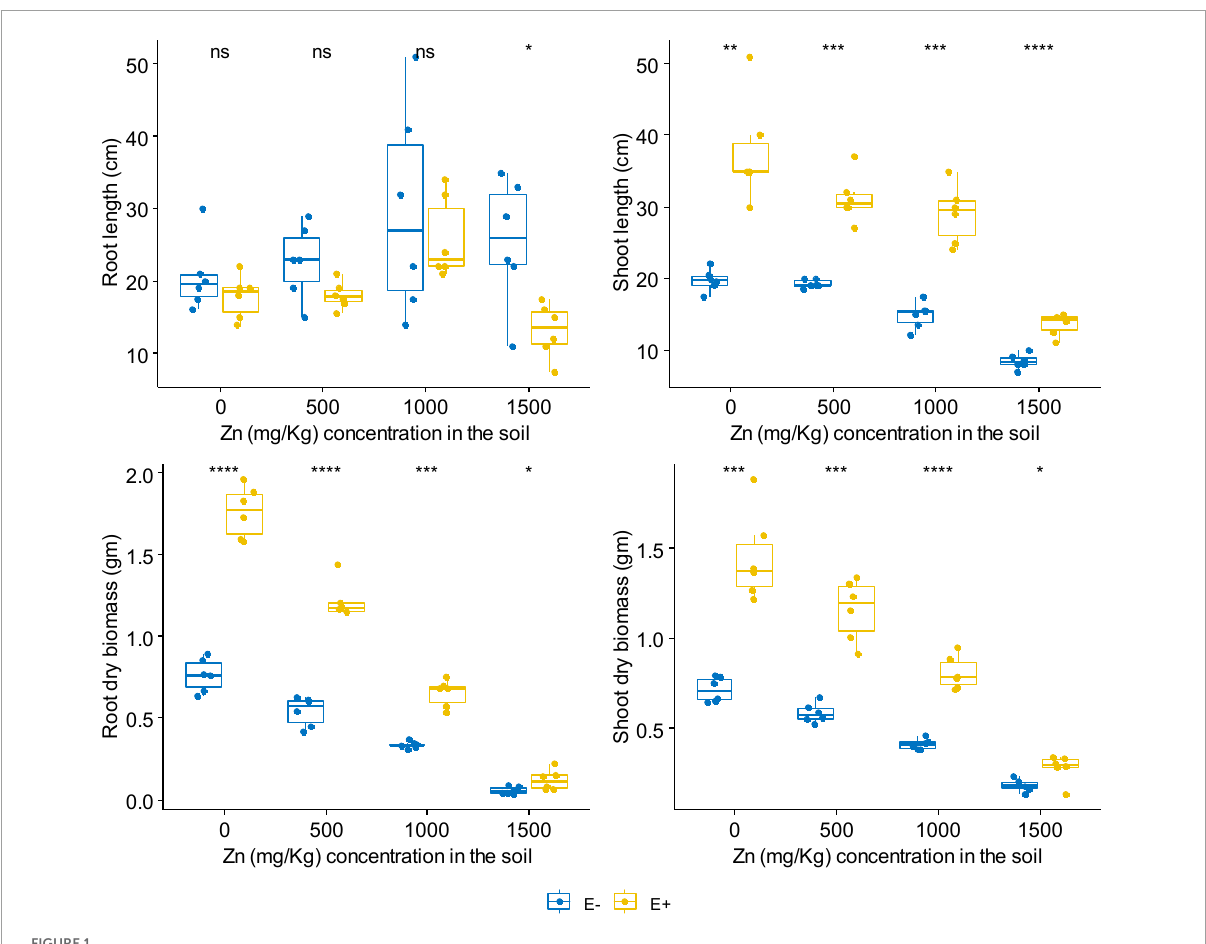
FIGURE1 The effect of FXZ2 on the growth of Dysphania ambrosioides under Zn stress (* p < 0.05, ** p < 0.005, *** p < 0.0005, **** p < 0.00005, ns p > 0.05 t -test).